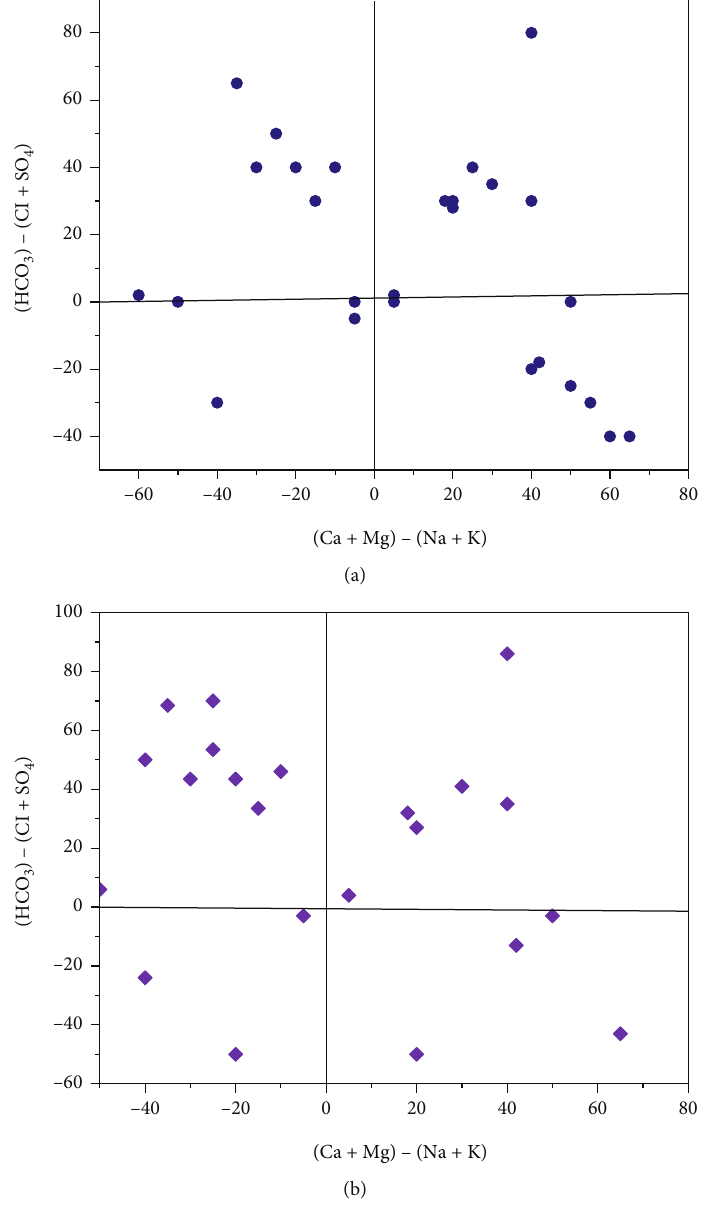
Figure 2: Diagram of Chadha. (a) Premonsoon. (b)